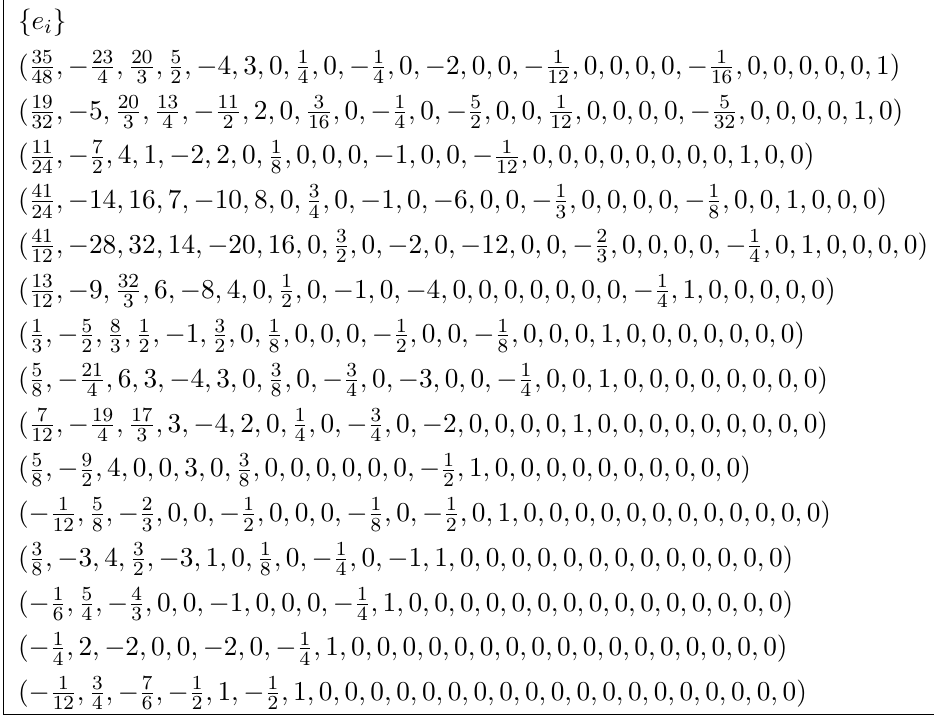
Table 4. Coefficients of quartic ETQT gravity for D = 4